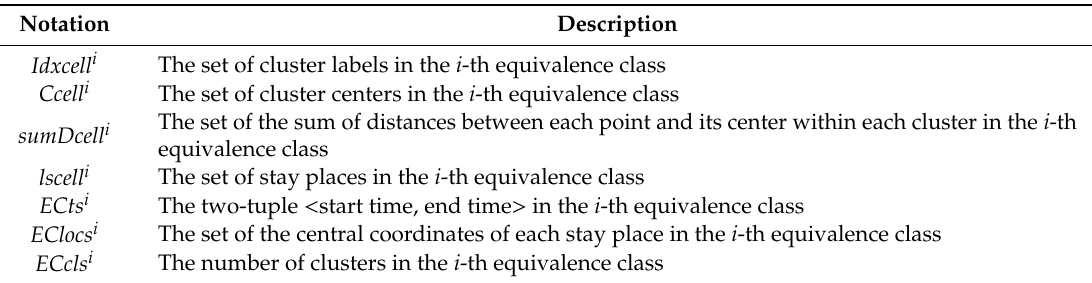
Table 1. Notations used in ClusterSP algorithm.